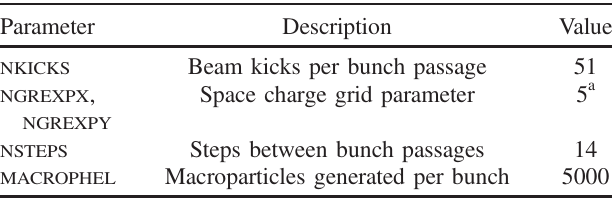
TABLE IV. Computational parameters in POSINST .